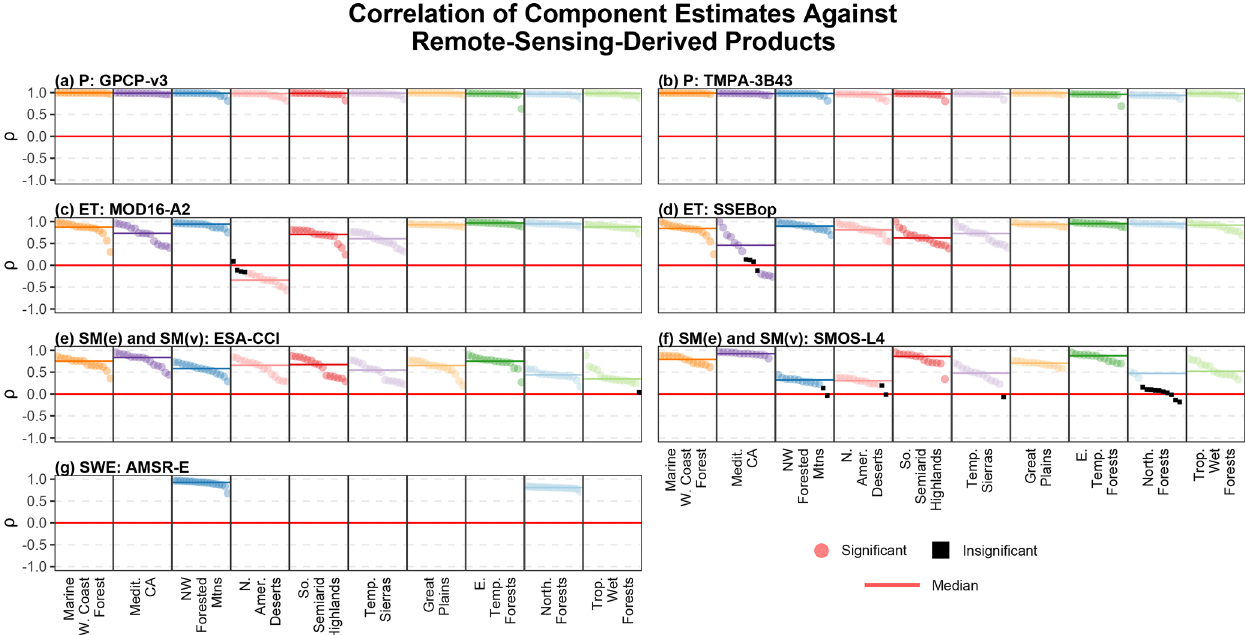
Figure 7. Spearman’s rho ( ρ) correlation values of hydrologic model and reanalysis data set component estimates against remote-sensing- derived products for components of precipitation ( P ), evapotranspiration (ET), soil moisture in units of both equivalent water depth (SM( e )) and volumetric water content (SM( v )), and snow water equivalent (SWE). The title of each sub-plot (e.g., Fig. 7a) provides the hydrologic component (e.g., P ) and the remote sensing product against which the data set was correlated (e.g., GPCP-v3). Statistically significant ρ values ( p< 0 . 05) are shown as colored circles. Insignificant ρ values ( p> 0 . 05) are shown as black squares. Horizontal bars within each ecoregion denote mean ρ . Point and bar colors correspond to ecoregions, as shown in Fig. 1. Each point or square corresponds to a single modeled data set, with points sorted by descending ρ value. More detailed information can be found in Fig.